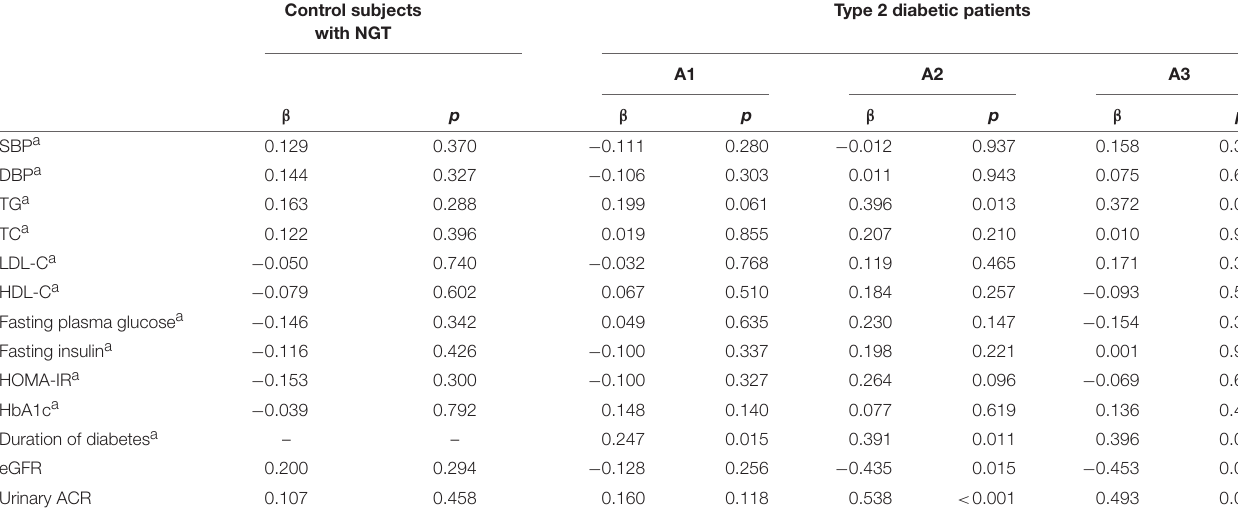
TABLE 3 | Multivariate regression analysis with ANGPTL8 as dependent